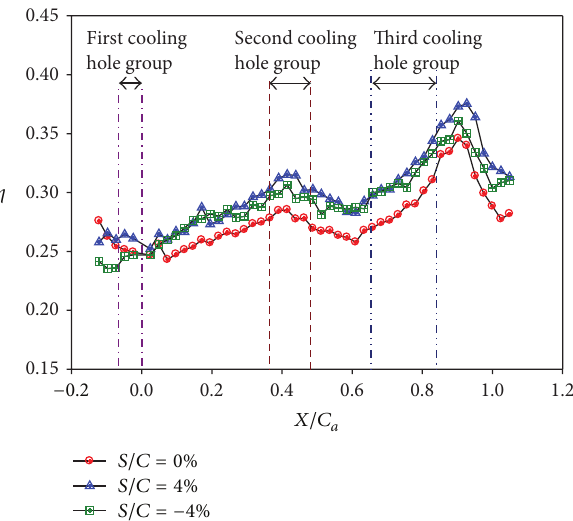
Figure 17: Effect of stepped endwall on averaged effectiveness at low turbulence intensity (Re = 124000 , 𝑀 = 1 , and T . I . = 1.8